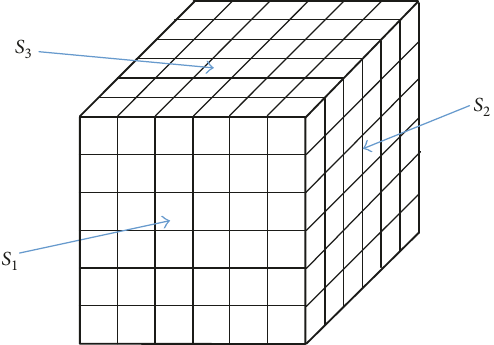
Figure 5: Schematic diagram of discretization of boundary surfaces for closed